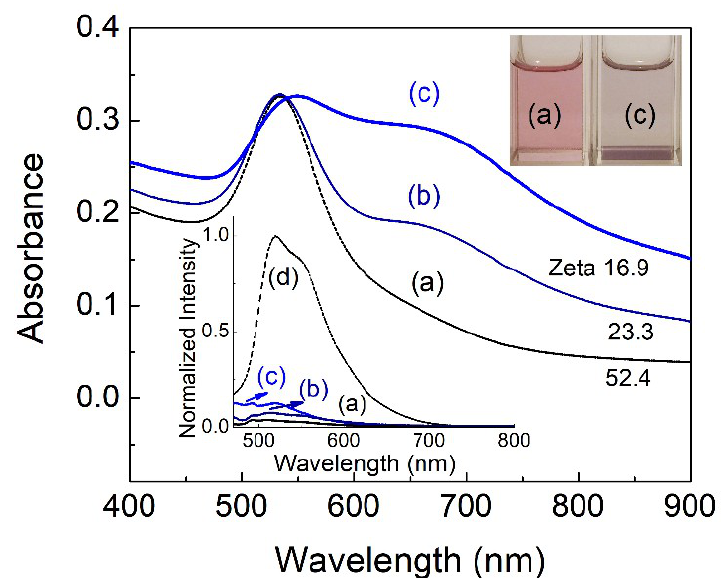
Figure 6. ( a ) Absorbance spectra of Au-NPs in ethanol and of centrifuged compound 2 homogenized with Au-NPs for ( b ) 5 min with sonication and ( c ) with 20 h of magnetic stirring. The insets show the emission for ( a – c ) and compound 2 in ethanol (1 × 10 − 5 mol/L) ( d ) at λ e = 430 nm and the Z-potential values (Zeta in mV).